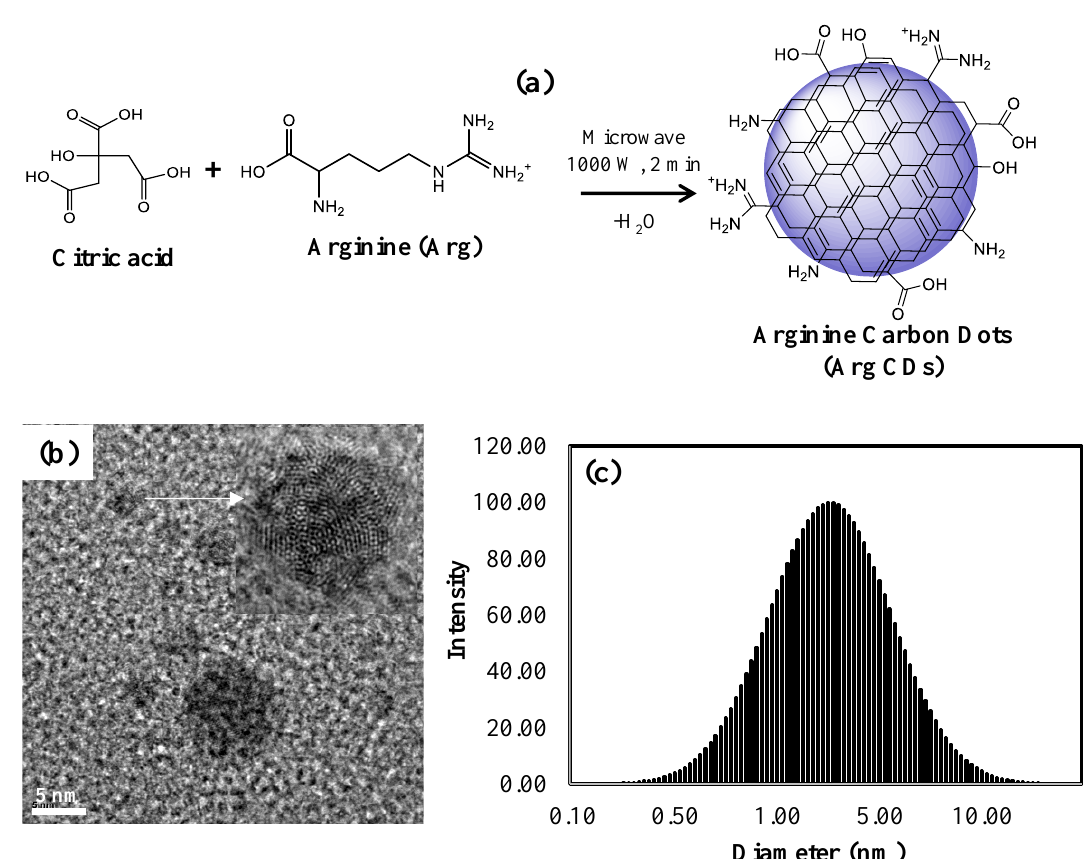
Figure 1. ( a ) Schematic representation of the preparation of graphitic arginine carbon dots (Arg CDs) by a microwave technique ( b ) its TEM image and ( c ) particle size distribution by dynamic light scattering (DLS).